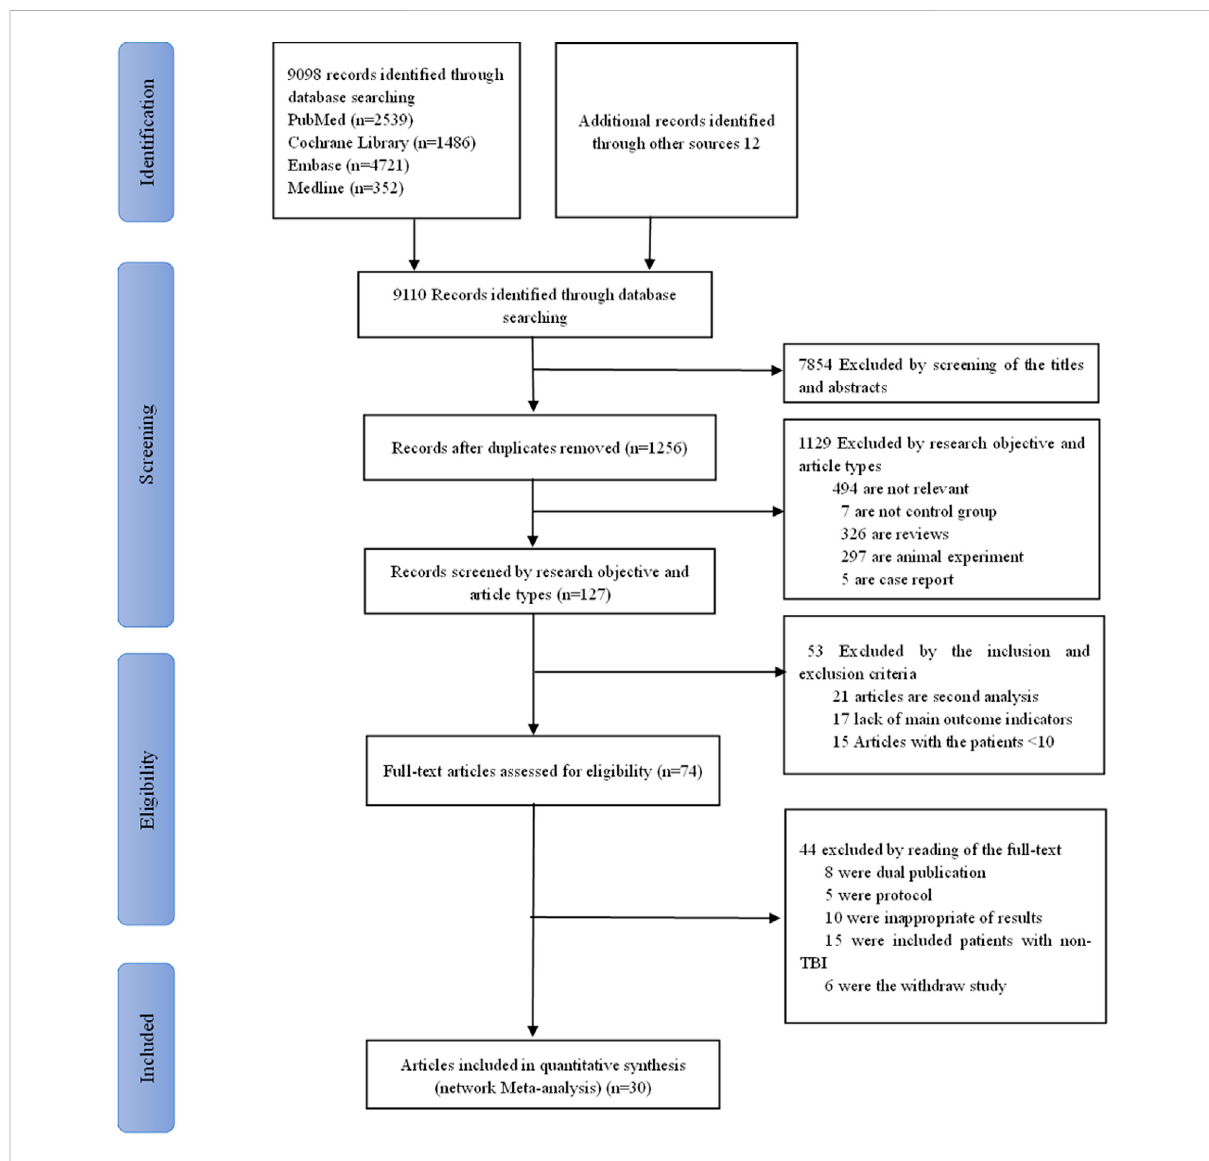
FIGURE 1 Flow chart of the study selection